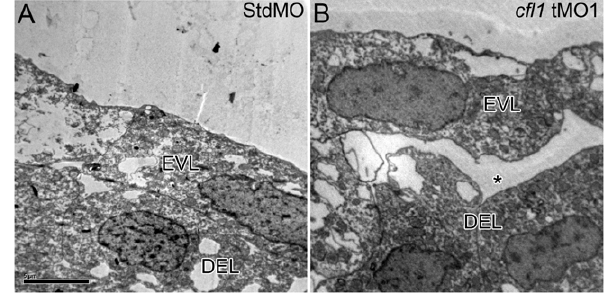
Figure 6. Loss of Cfl1 causes disruption of the attachment between the EVL and DEL. Embryos injected with either the StdMO (A) or c fl1 tMO 1 (B) were fixed at 8.5 hpf and subjected to transmission electron microscopy. Cohesive attachment between the EVL and DEL on lateral sites of embryos was observed in StdMO-treated control embryos, but a cleft (aster) was observed in cfl1 morphants. Each photograph is representative of at least five embryos with similar results.